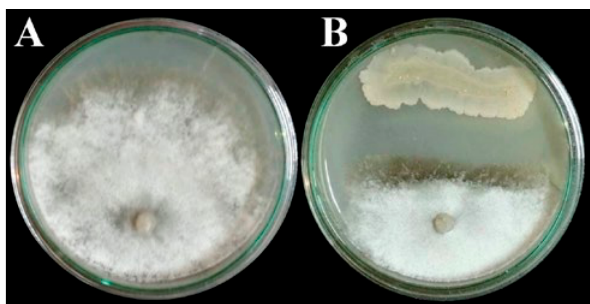
Figure 1. In vitro antifungal activity of Bacillus amyloliquefaciens GGA against Sclerotium cepivorum S6 (8-d old cultures). A, a PDA plate of S. cepivorum S6; B, a dual culture plate of S. cepivorum S6 and B. amyloliquefaciens GGA .